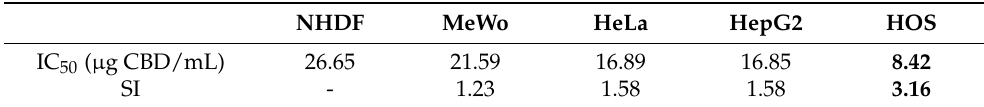
Table 4. IC 50 and SI values of CBD-enriched hemp oil toward NHDF, MeWo, HeLa, HepG2 and HOS cell